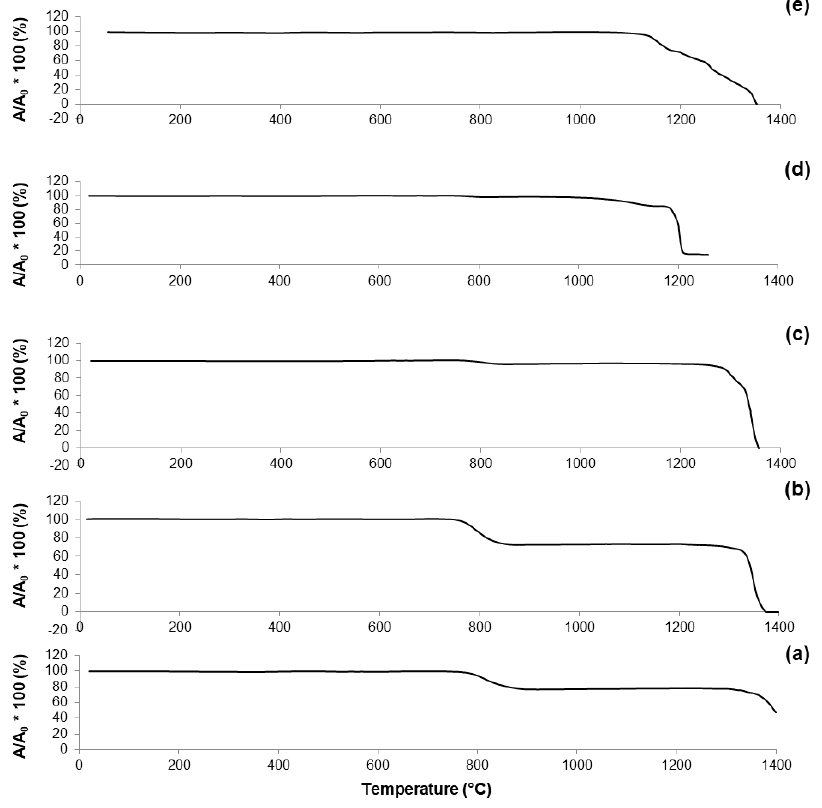
Figure 4. HSM plots (shrinkage variations) of: ( a ) 60S40C-air (measurement performed in air); ( b ) 60S38C2Fe-air (measurement performed in air); ( c ) 60S38C2Fe-Ar (measurement performed in argon); ( d ) 60S30C10Fe-air (measurement performed in air); and ( e ) 60S30C10Fe-Ar (measurement performed in argon).